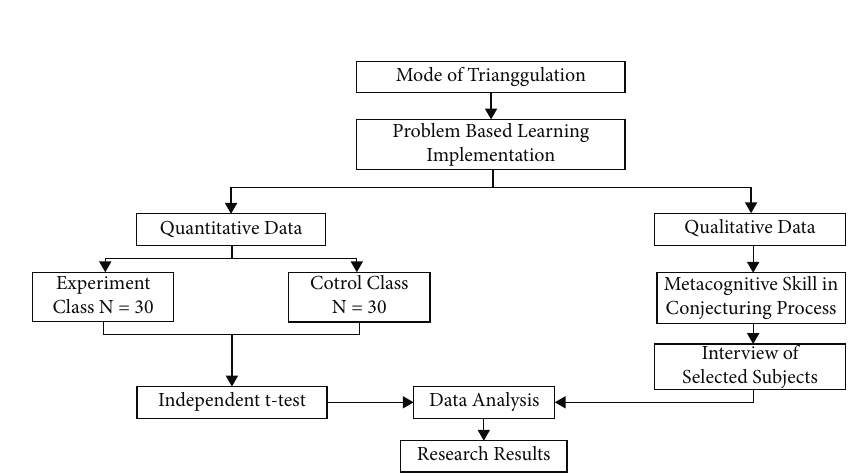
Figure 1: Mode of triangulation.